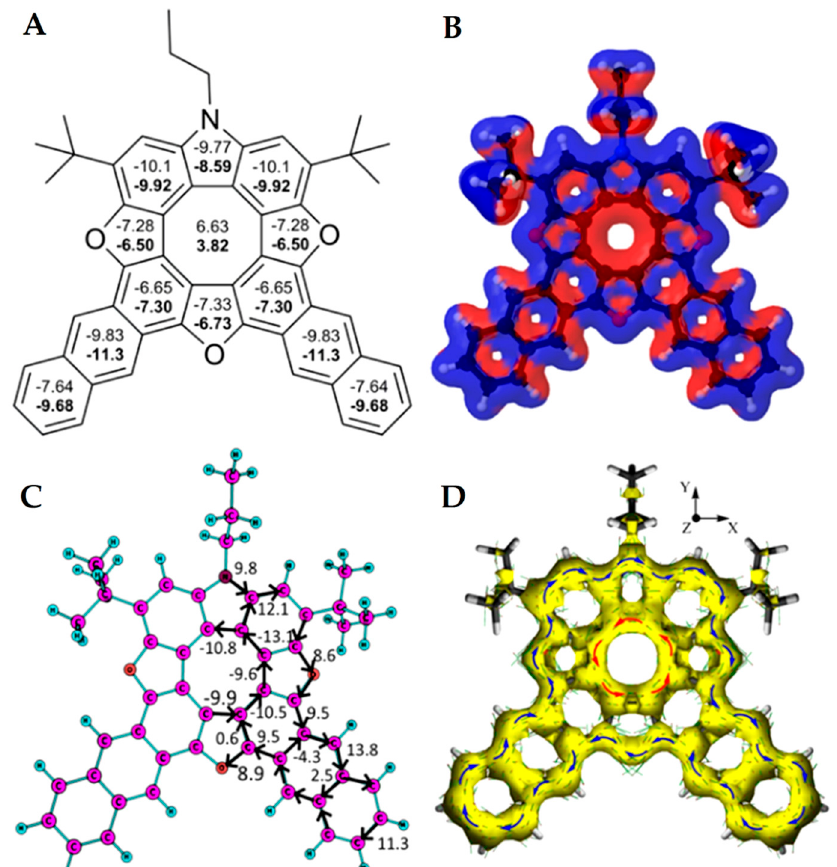
Figure 21. NICS(0) and NICS(1) (in bold) indices ( A ), the signed modulus of the MIC densities ( B ), MIC strengths vs. MIC pathway ( C ) and anisotropy of the induced current density plot ( D ) for the dianthracenylazatrioxa[8]circulene molecule. Paratropic current densities are shown in red and the diatropic ones are shown in blue in ( B ) [26].